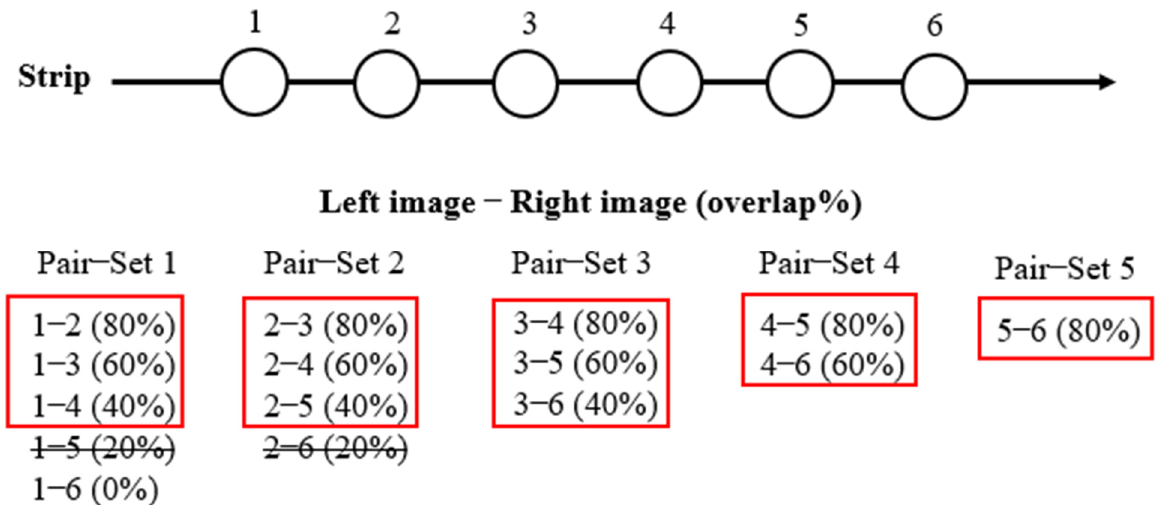
Figure 4. Example of the pair sets in a strip with six images .